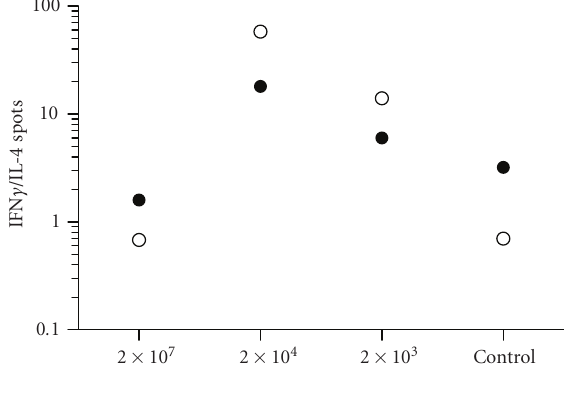
Figure 4: Ratio of IFN γ to IL-4 spots in the mice depicted in Figure 3. Ratios were calculated as the mean number of antigen- specific IFN γ spots/the mean number of IL-4 spots within each group of mice. Open circles and filled circles represent BCG- and β gal-specific IFN γ : IL-4 ratios,